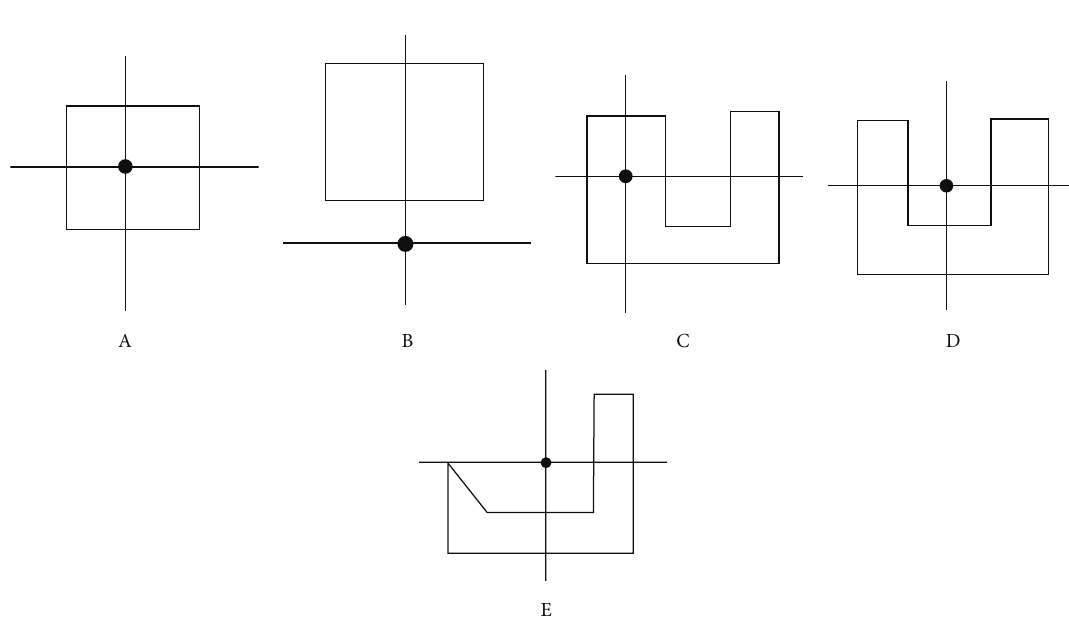
Figure 1: Positional relationship between the substation and the area.